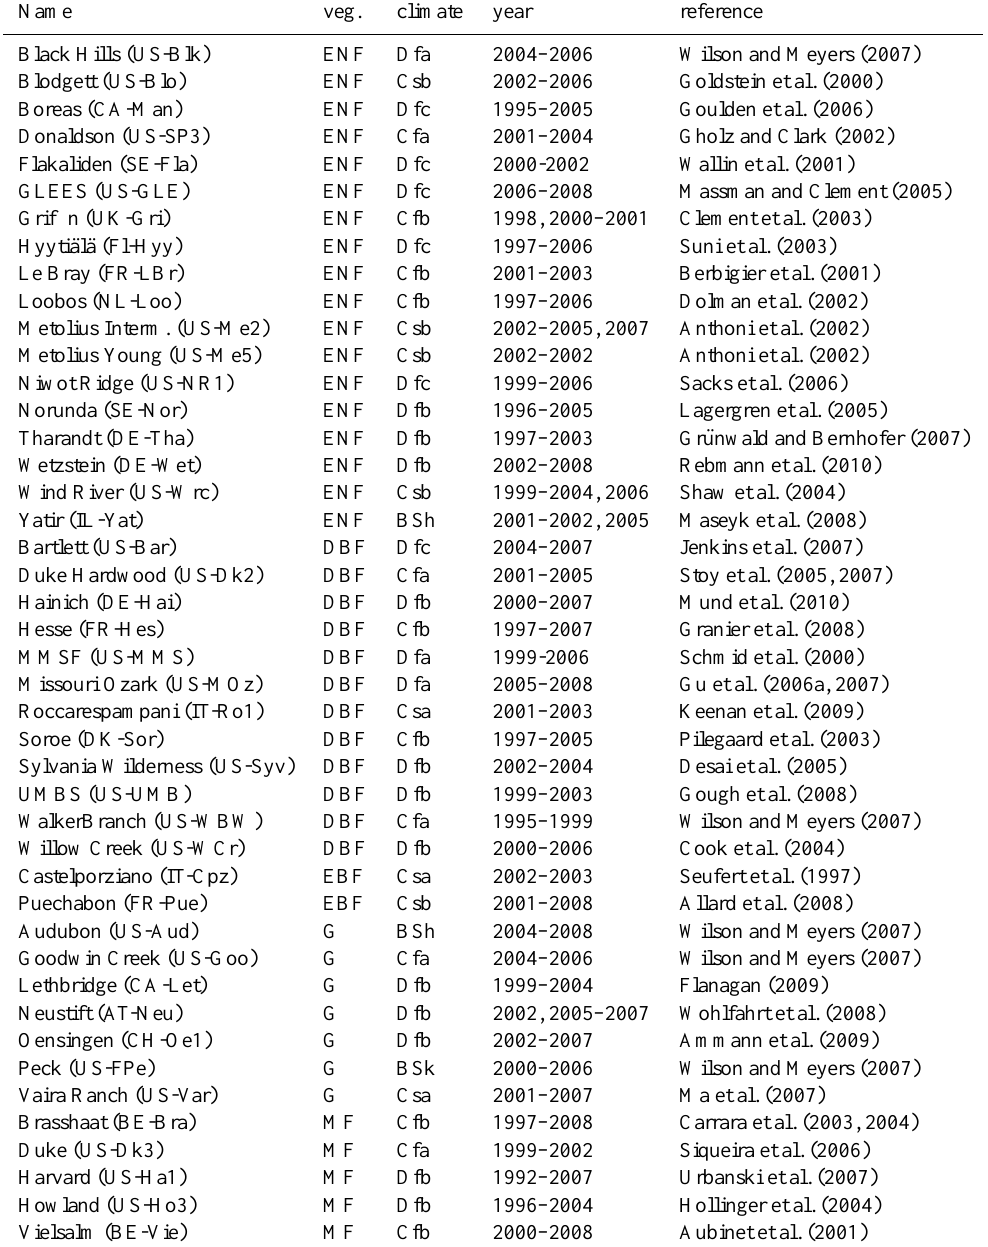
Table 1. Name, vegetation (veg.) and climate class, measurement years utilized in this study, and reference for the study sites. Koeppen- Geiger-climate classes: steppe climate (BS), temperate (C), continental (D); summer dry (s), fully humid (f); hot (h), cold in winter (k); hot summer (a), warm summer (b), cool summer (c), cold winter (d); vegetation types: deciduous broadleaf forest (DBF), mixed (MF), evergreen needleleaf (ENF), evergreen broadleaf (EBF), grass